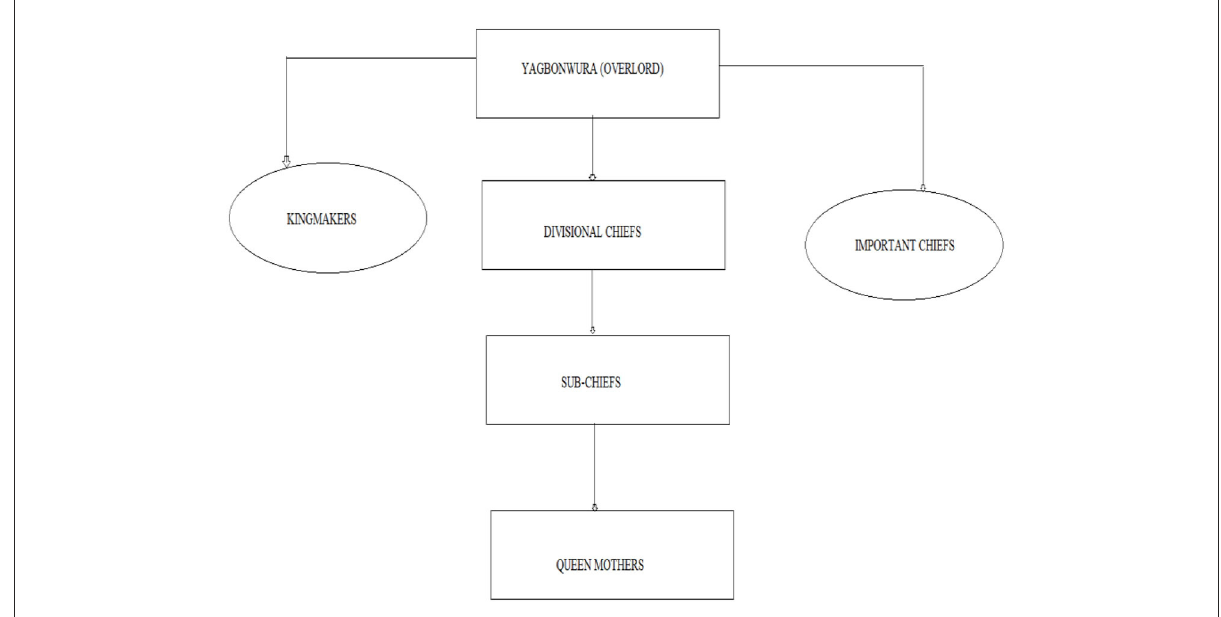
FIGURE1 Traditional Governance Structure of the Gonja